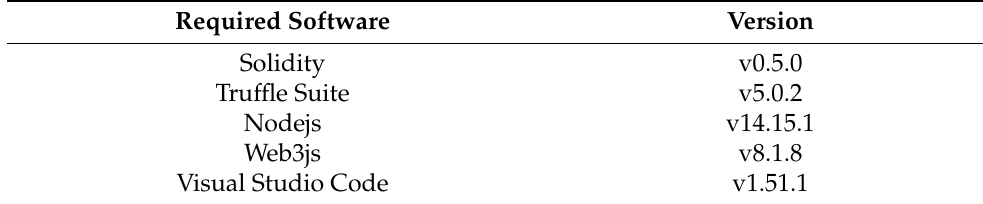
Table 2. Software used with versions